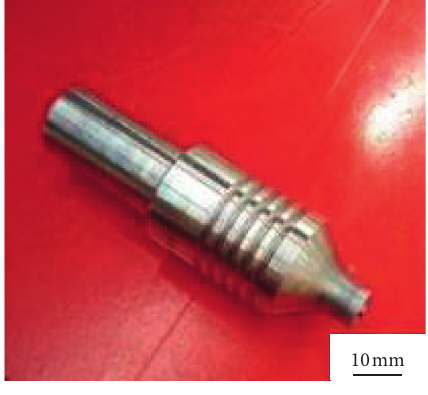
Figure 2: Mixing tool.